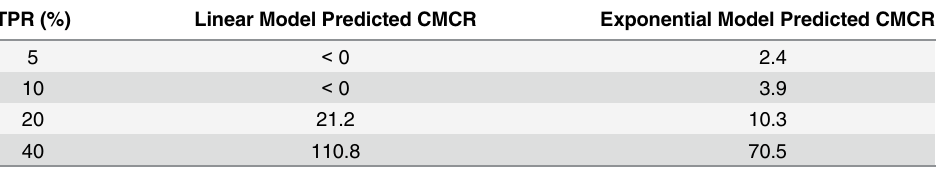
Table 3. Comparison of predicted confirmed malaria case rates (CMCR) at specified test positivity rates (TPR) using both linear and exponential growth regression models.